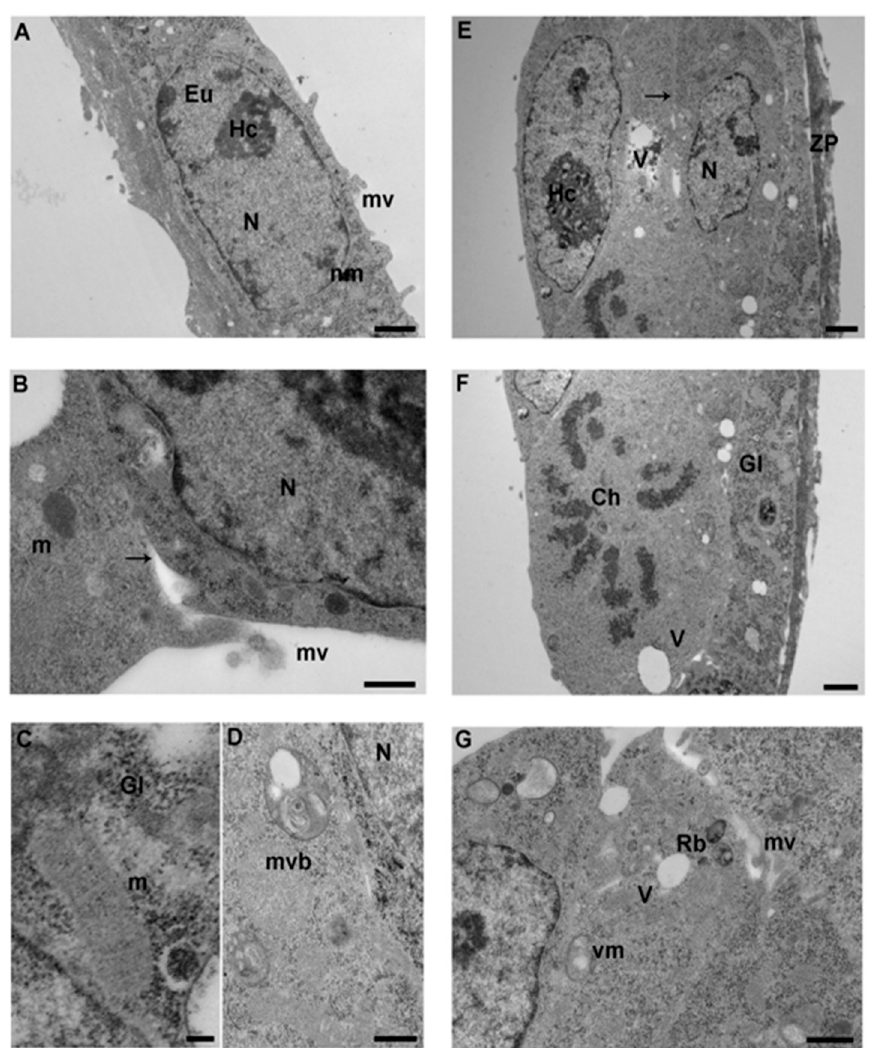
Figure 4. Ultrastructure of IVF-5% blastocyst. A. TEM micrograph of a TE cell with a large nucleus (N). (TEM. Bar: 1 µm). B. Intercellular junction (arrow) between TE cells (TEM. Bar: 0.6 µm). C. TEM micrograph showing mitochondria (m) with evident cristae (TEM. Bar: 0.1 µm). D. High magnification of a multi-vesicular body (mvb) (TEM. Bar: 0.6 µm). E. Ultrastructure of ICM cells showing ovoid nuclei (N) with patches of heterochromatin (Hc). The inner cell shows numerous vacuoles (V). The arrow indicates the intercellular contacts (TEM. Bar: 1 µm). F. ICM blastomere with evident chromosomes (Ch) (TEM. Bar: 1 µm). G. ICM cells with the presence of vacuolated mitochondria (vm) and residual bodies (Rb) (TEM. Bar: 0.8 µm). N: nucleus; nm: nuclear membrane; m: mitochondria; vm: vacuolated mitochondria; mv: microvilli; Hc: heterochromatin; Eu: euchromatin; Gl: glycogen granules; mvb: multivesicular body; ZP: zona pellucida; V: vacuoles; Rb: residual bodies.